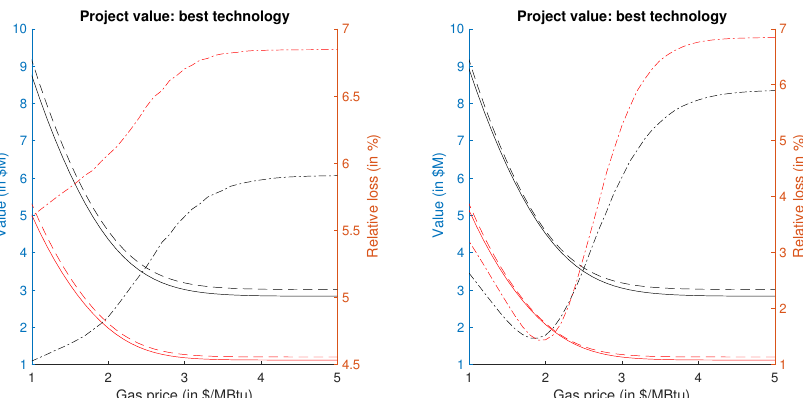
Figure 7. This figure displays the value function (solid left scale) and the relative loss in project value (dot-dashed on right scale) as functions of Y for the best of two technologies at t = 0 (black) and t = 0.3 (red) in case of low sensitivity of the gas price ( C = 0, left panel ) and of high sensitivity ( C = 2.5, right panel ). The value of X t is 50$/MWh. Solid line corresponds to the pandemic case, dashed line to the no-pandemic case. Parameter values are given in Table 1; the investment horizon is T = 1 year.